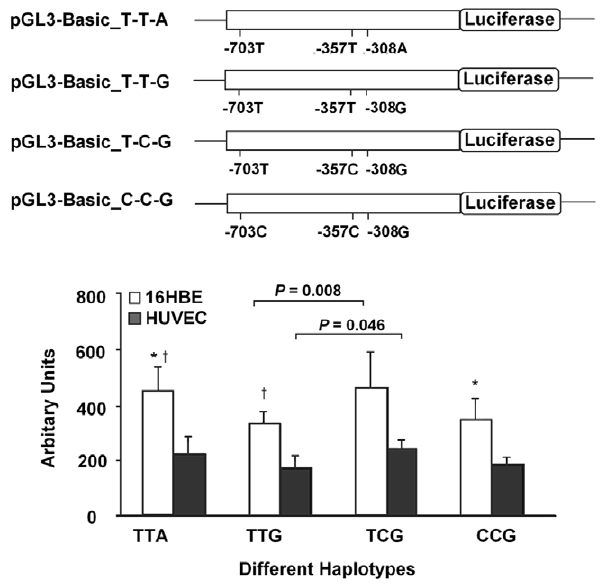
Figure 3. Effects of haplotypes in promoter of HSPA8 on luciferase activity. Transient luciferase reporter gene expression assays with constructs containing different haplotypes of HSPA8 promoter in human bronchial epithelial cells (HBE) and human umbilical vein endothelial cells (HUVEC). Upper: schematic representation of different reporter gene constructs. Variants of -703C/T, -357C/T, and -308A/G represent rs2236660, rs2236659, and rs2236658 respectively; Lower: luciferase expression of these constructs. All constructs were cotransfected with pRL-SV40 to standardize the transfection efficiency. Fold increase of luciferase activity was calculated by defining the activity of the empty pGL3-Basic vector as 1. All experiments were performed in triplicates at least in three independent transfection experiments and each value represents mean (standard deviation). *and { indicated that P , 0.05, compared with each of the